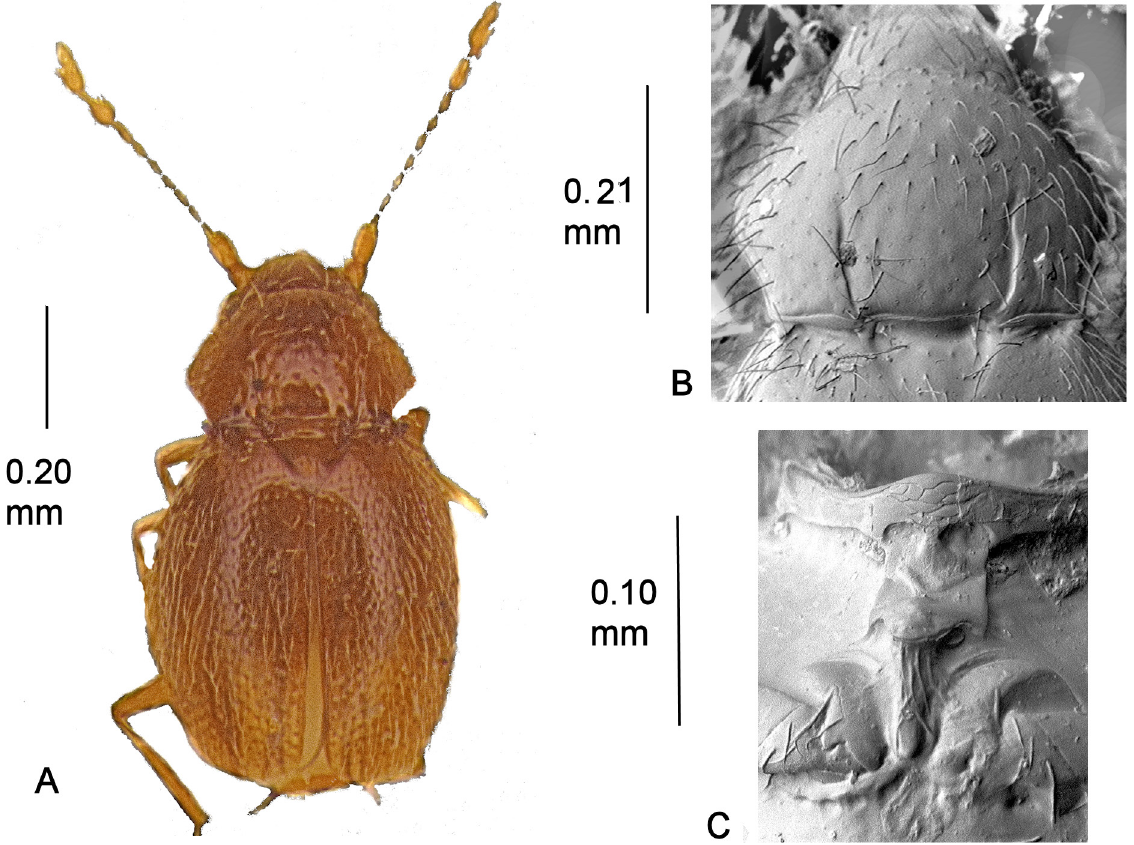
Fig. 66. Cissidium bilineatum sp. nov. A . Habitus. B . Pronotum, × 395. C . Mesoventrite showing median process of collar, mid-keel and keel,